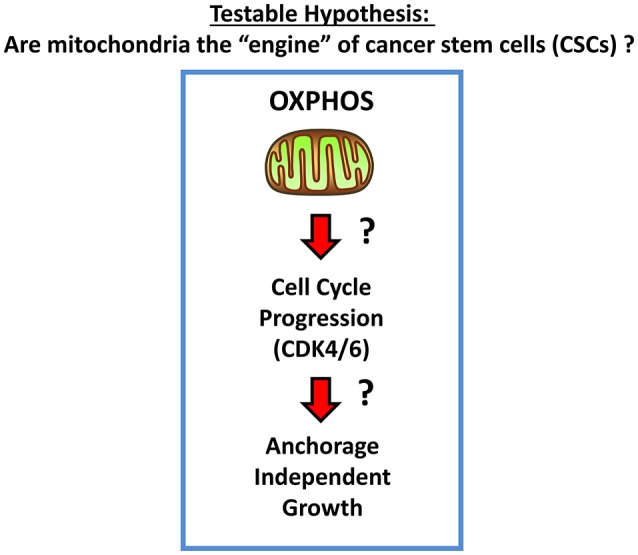
Mitochondria and CSCs. Here, we propose the testable hypothesis that mitochondria are the “engines” that drive cell-cycle progression and proliferation in CSCs, especially under anchorage-independent growth conditions.